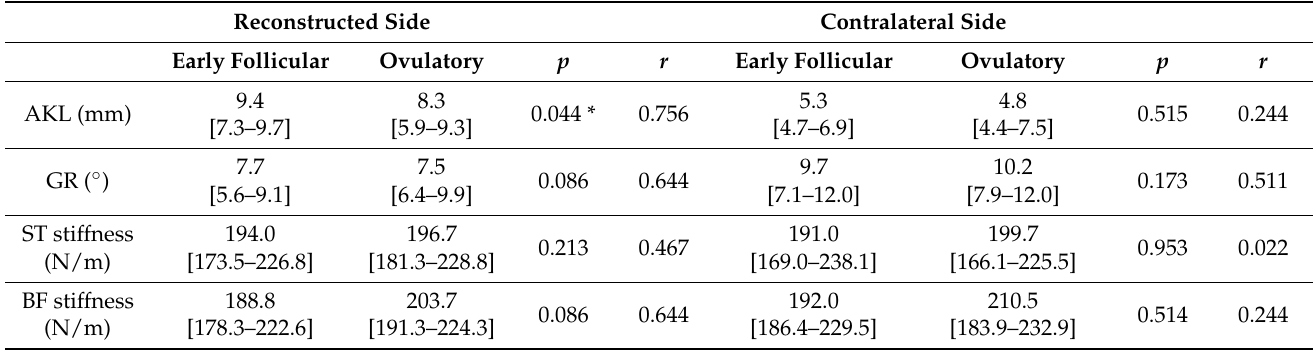
Table 3. Comparison of the early follicular and the ovulatory Table 2. E2 concentration, AKL side-to-side difference.